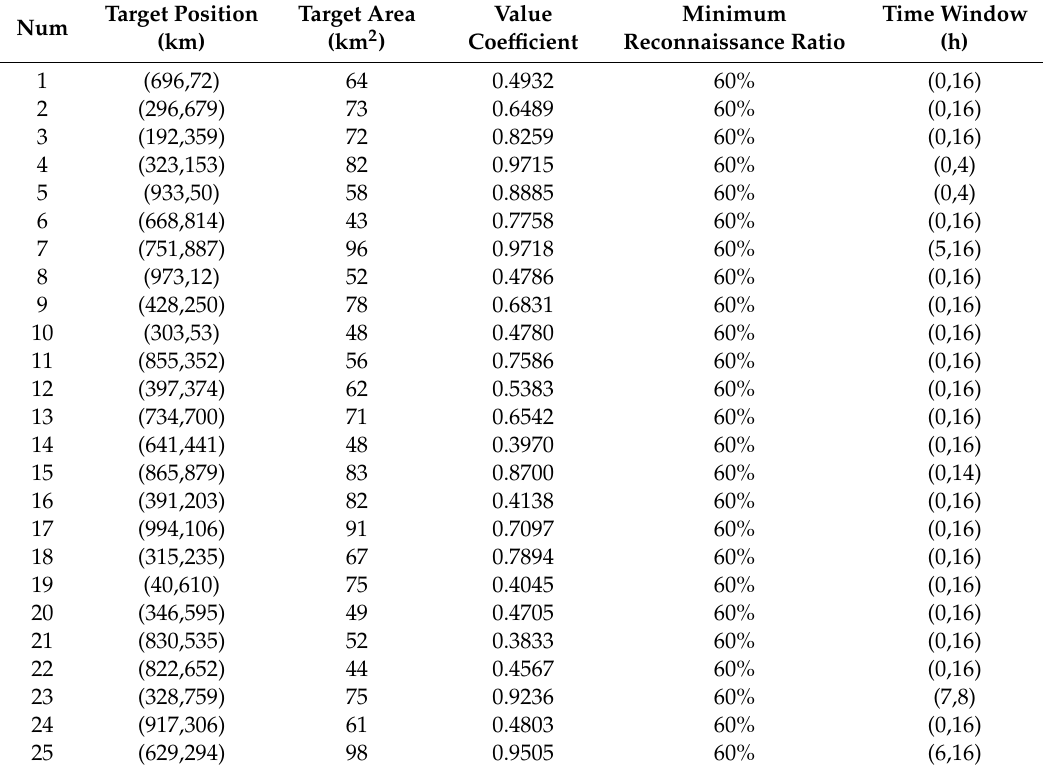
Table A2. Information of target area.